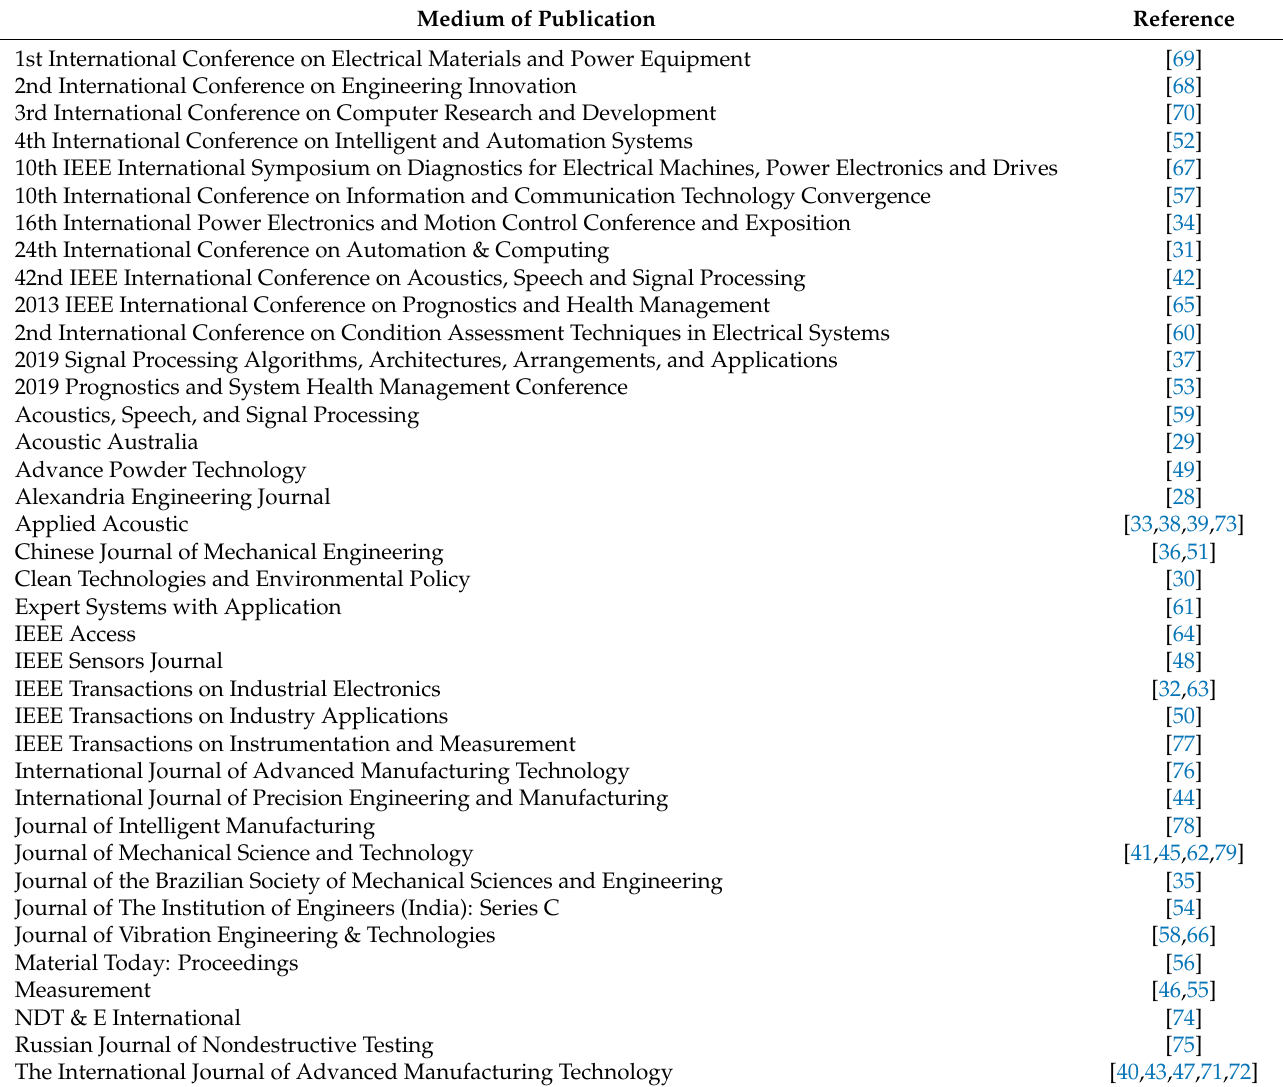
Figure 5. Categories of publication. Table 6. Medium of